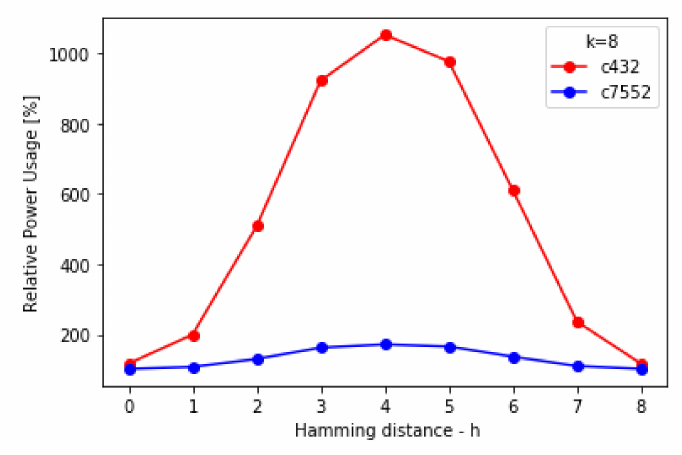
Figure 24. Relative power usage increase in locked netlists for different values of Hamming distance.